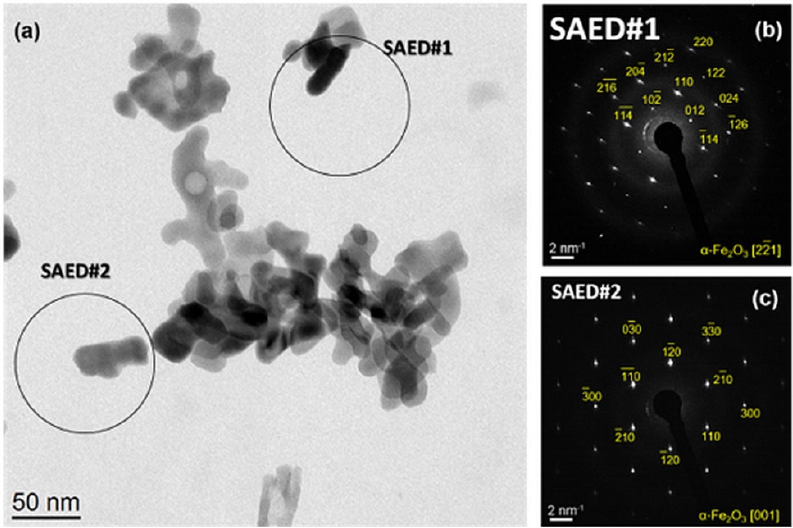
Figure 4. Bright ‐ field TEM image of sample Fe 2 O 3 _NH ‐ 500 ( a ) and SAED patterns of two differently Figure 4. Bright-field TEM image of sample Fe 2 O 3 _NH-500 ( a ) and SAED patterns of two differently oriented hydrohematite particles ( b , c ). oriented hydrohematite particles ( b , c